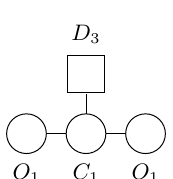
Figure 15 . Higgs branch quiver with D 3 (cid:17) A 3 global symmetry. Note that O 1 (cid:17) Z 2 and C 1 denotes Sp(2), dim M H = H